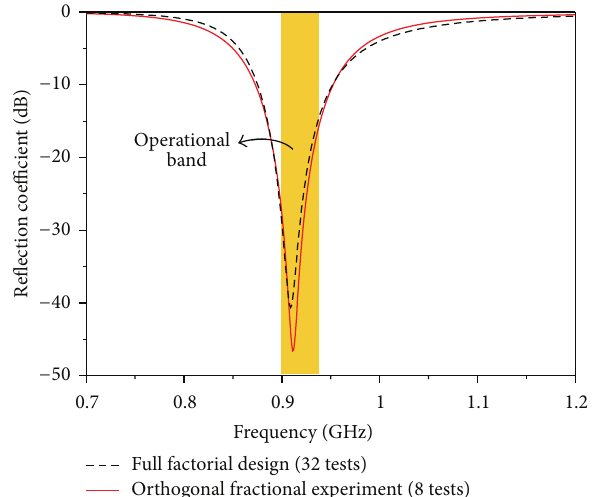
Figure 3: Comparison of the optimized inductive-feed meander dipoles between the full factorial design and the orthogonal frac- tional experiment.